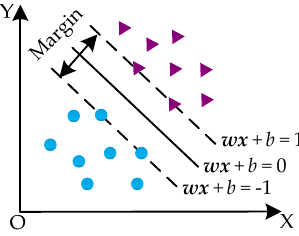
Figure 6. The classification principle of SVM.